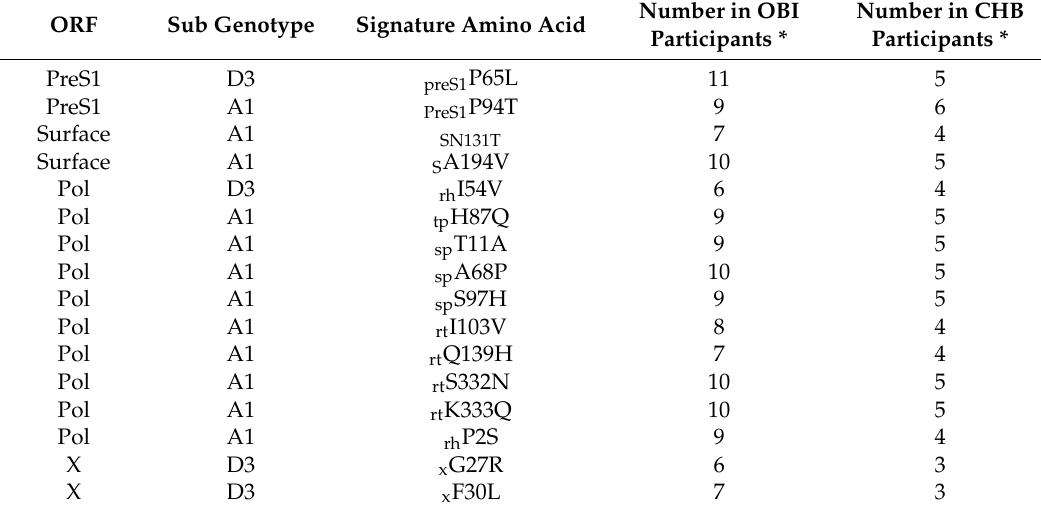
Table 6. Signature amino acids found mostly in HBV sequences from OBI participants compared to sequences from CHB